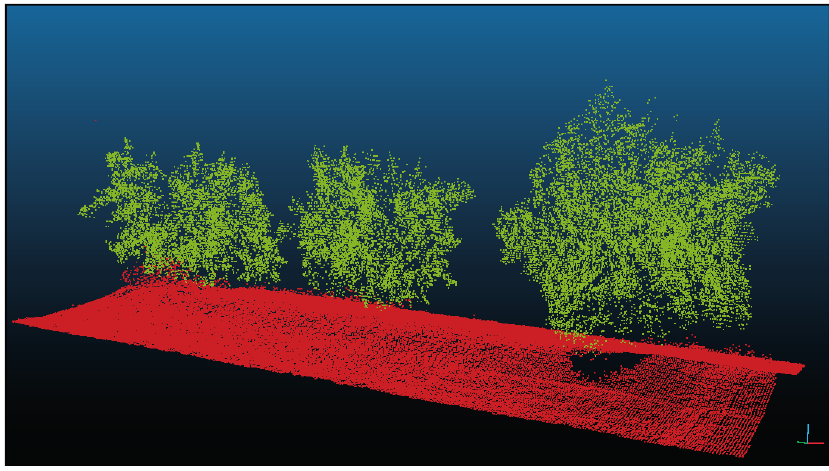
Figure 6. LiDAR cloud points obtained after scanning three contrasting trees on the same row. This cloud of points was used to estimate the tree